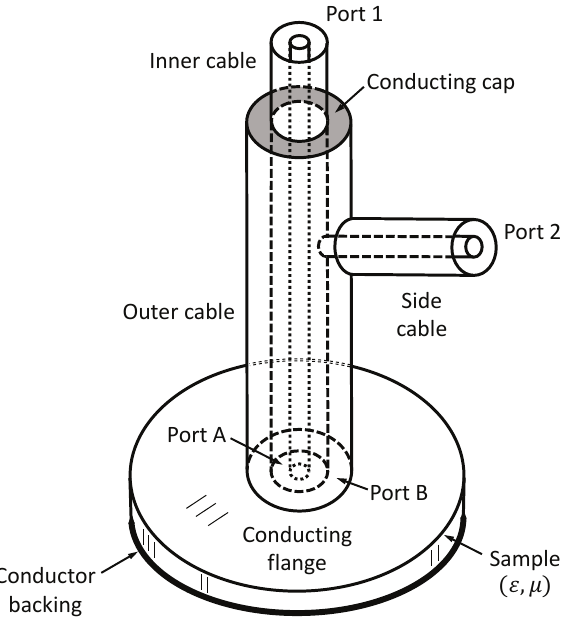
Figure 1. Geometry of the triaxial